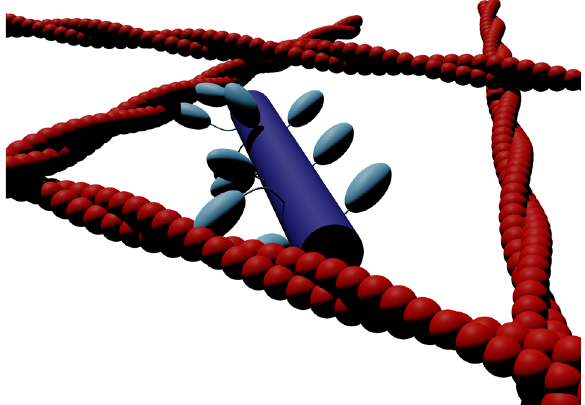
FIG. 1. Schematic of a cytoskeletal assembly composed of multiple molecular motors. Drawing is to scale for actin filaments (red) and myosin motors (blue).